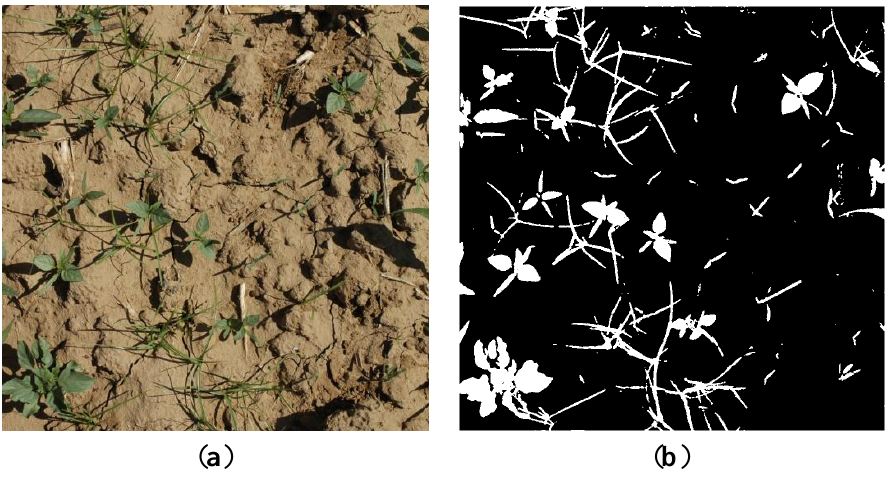
Figure 4. ( a ) Mixed monocots and dicots; ( b ) Segmentation of the vegetation cover of image